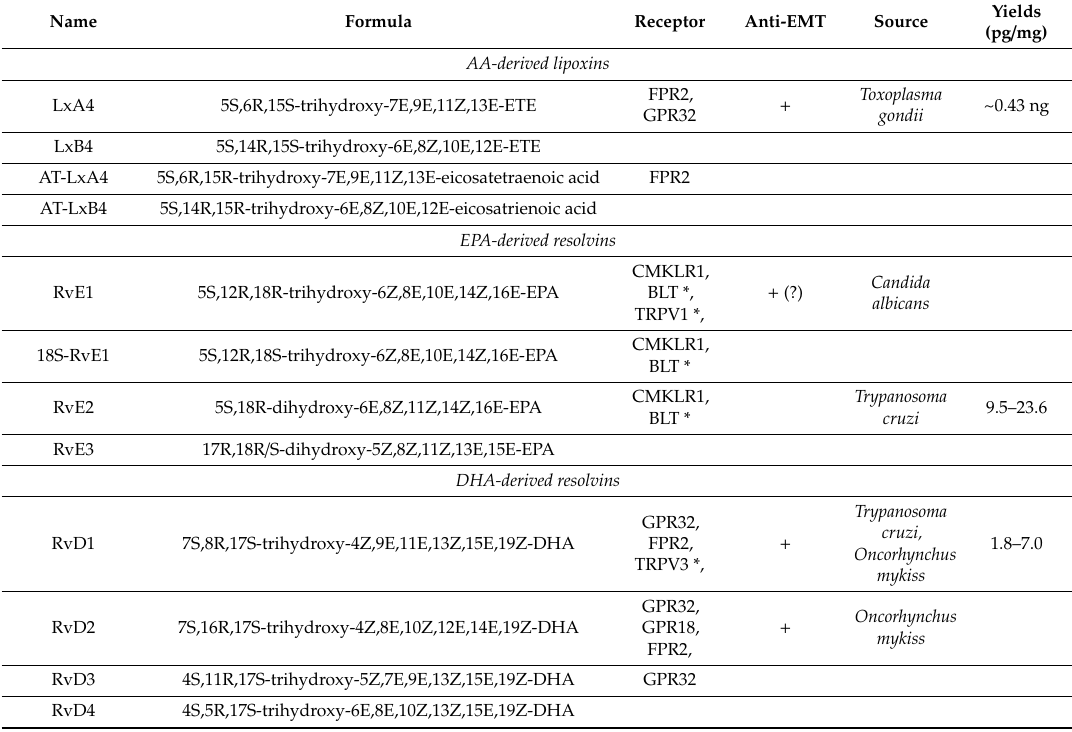
Table 2. Pro-resolving lipids. *